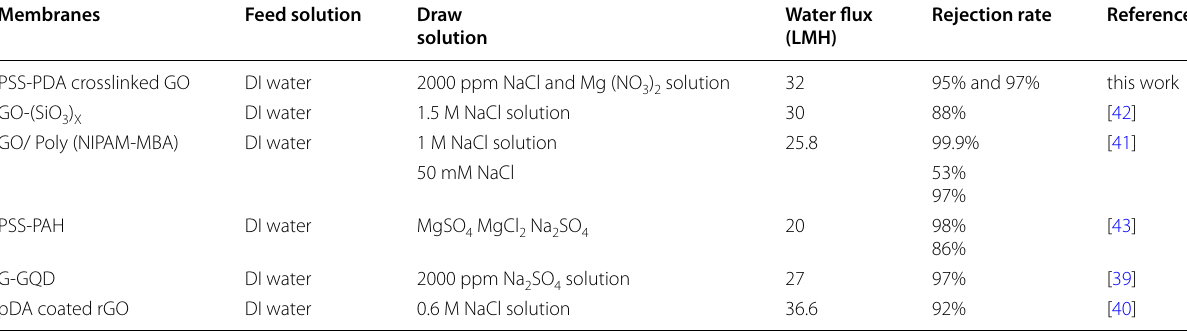
Table 2 Comparison studies of rejection of some FO membranes published in the literature Membranes Feed